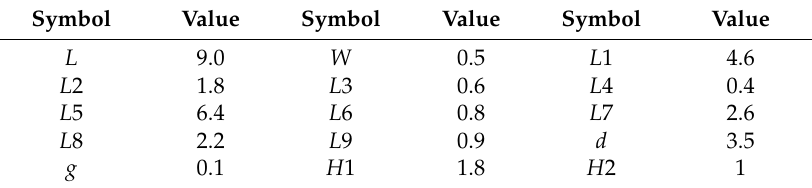
Figure 2. Geometry of the proposed antenna at: ( a ) Top view; and ( b ) side view. Table 2. Dimensions of the proposed antenna parameters (unit: mm).